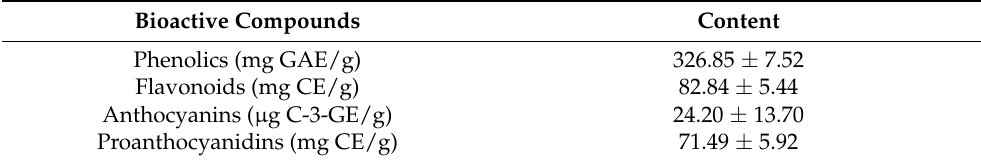
Table 1. Bioactive compounds in RRBE.